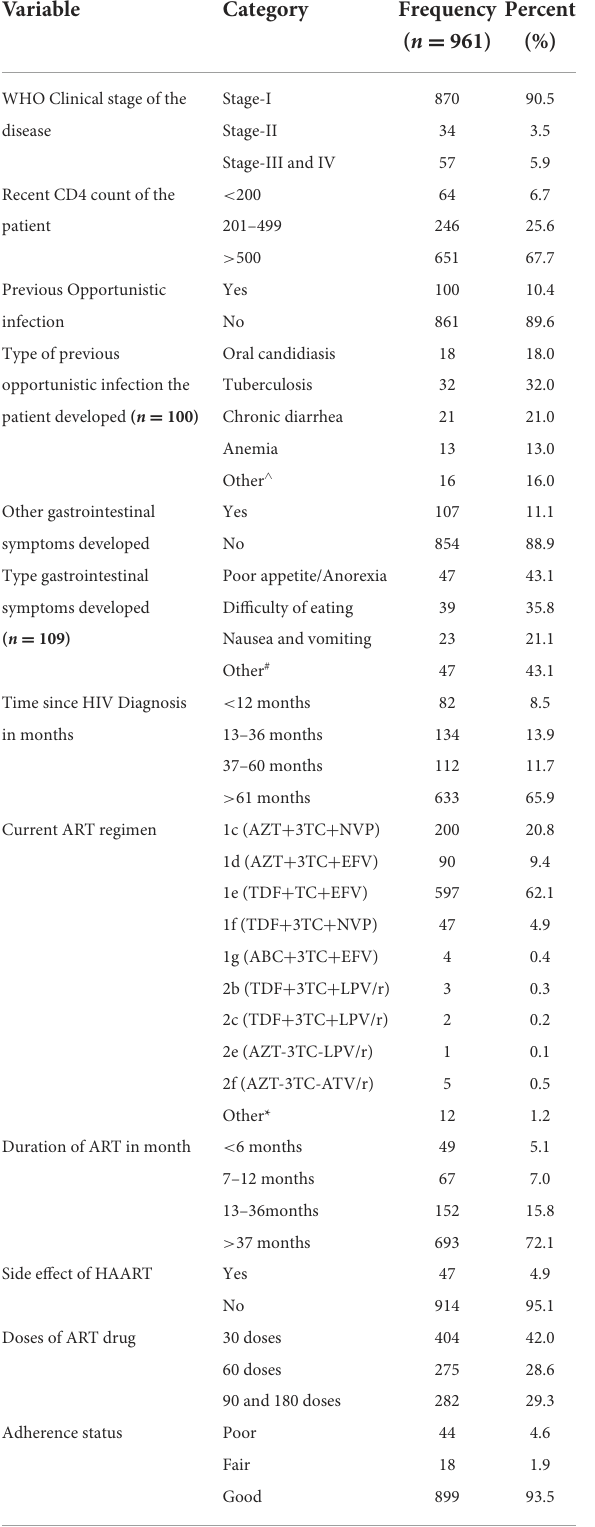
TABLE 3 Variable related to the medical factor of the study participants at Bench Maji Zone, southwest, Ethiopia, 2018. Variable Category Frequency Percent